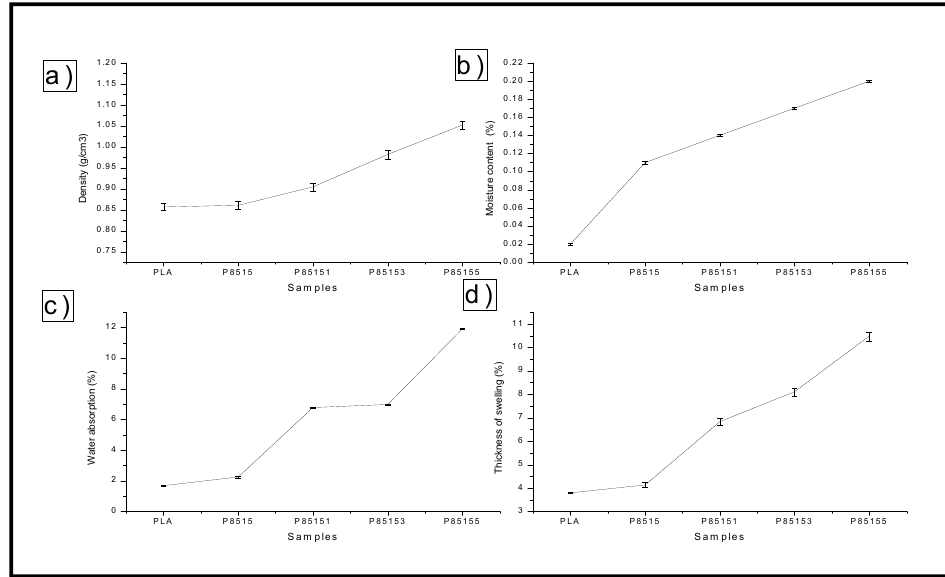
Figure 9. Physical properties ( a ) Density, ( b ) Moisture content, ( c ) water absorption, ( d ) Thickness swelling for neat PLA, P8515, P85151, P85153, and P85155 biocomposites.